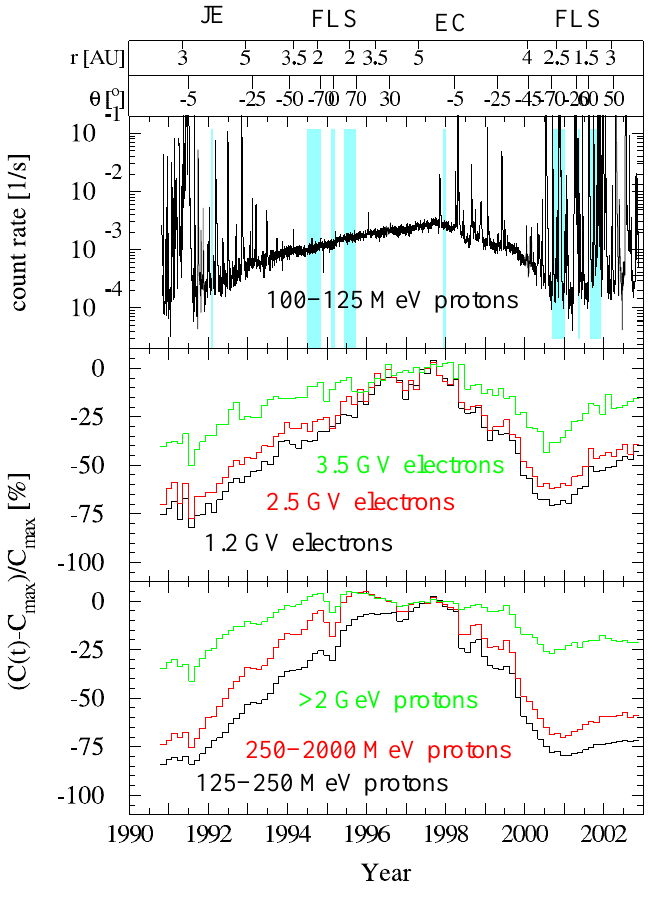
Fig. 4. From top to bottom: Daily averaged count rate of 100–125 MeV (0.3 GV) protons and 52-day “quiet time” count rates of 1.2 GV (black), 2.5 GV (red), and 3.5 GV (green) electrons, and 125–250 MeV (0.8 GV, black), 250–2000 MeV (2.5 GV, red) and > 2 GeV (6 GV, green) protons. Ulysses’ distance to the Sun and its heliographic latitude are shown on